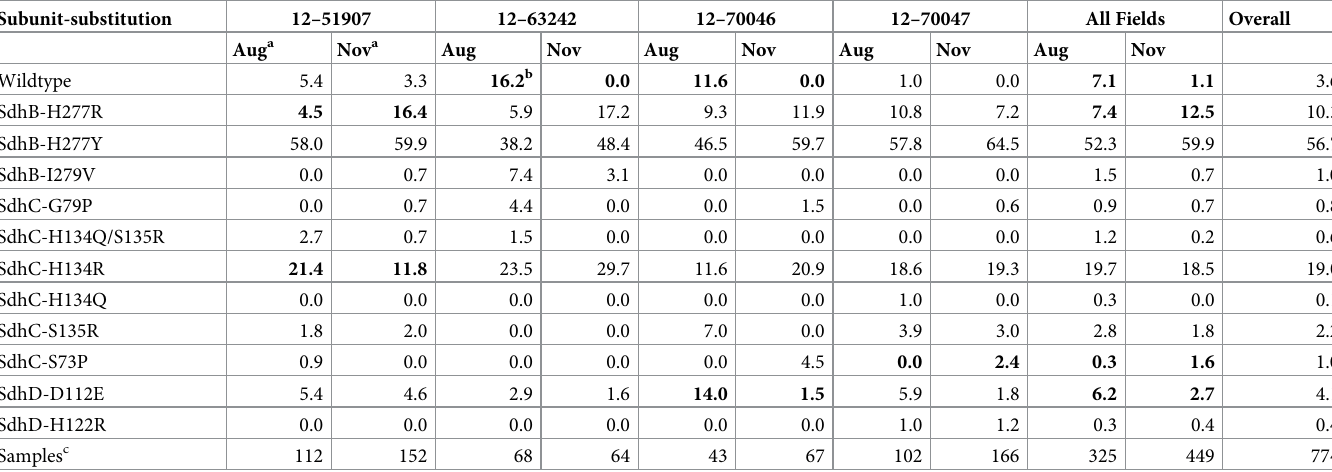
Table 2. Frequency (%) of each SDH substitution in the 2012 Didymella tanaceti population by sampling period and field.